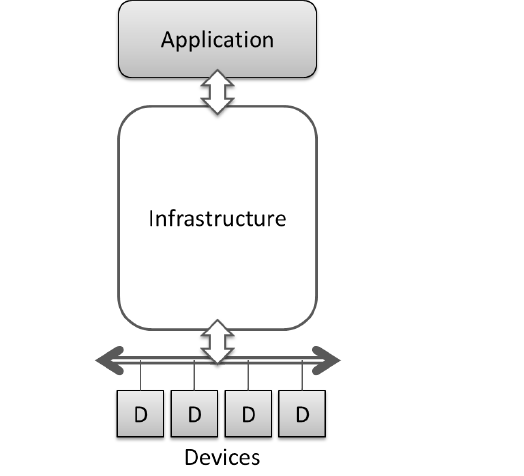
Figure 1. High-level view of legacy information technology (IT)